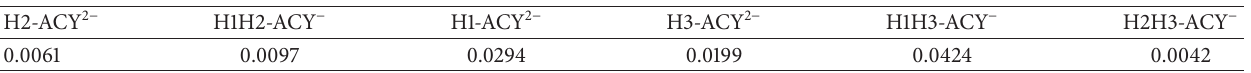
Figure 12: Isodensity surfaces (0.03 e/bohr 3 ) of the key molecular orbitals of the dyes adsorbed on the TiO 2 nanocluster calculated at DFT/B3LYP/DZVP level in water. Table 8: Orbital overlap between the key molecular orbitals (the excited state of the dye and the conduction band edge of the substrate), calculated at DFT/B3LYP/DZVP